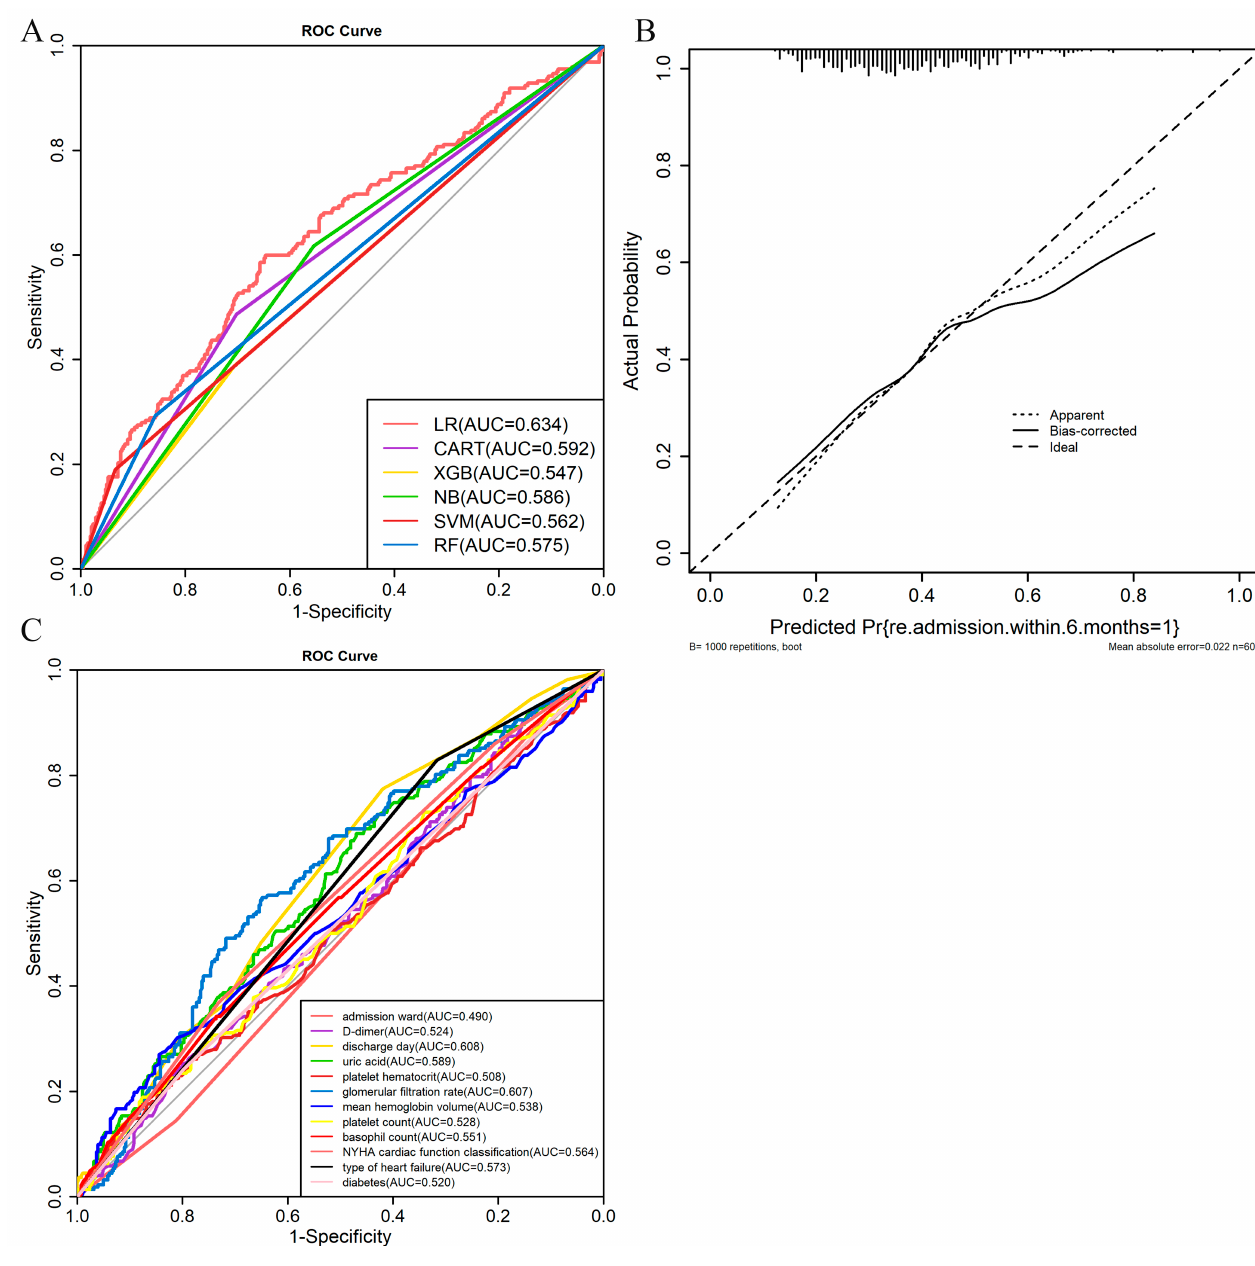
Figure 3. ( A ): The AUC of the 6 machine learning algorithms. ( B ): The calibration curve of the logistic regression model. The ideal line indicates that the model prediction is exactly the same as the actual situation, which is the ideal situation. Apparent and bias-corrected lines indicate the prediction performance of the LR model. Bias-corrected lines. Corrected over-fitting. ( C ): ROC analysis between the 12 clinical variables.